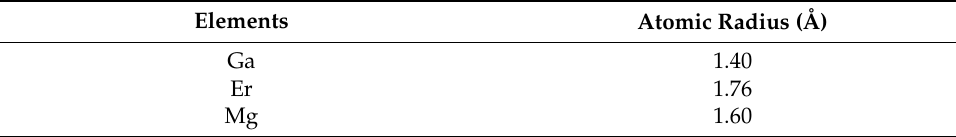
Table 1. The atomic sizes of